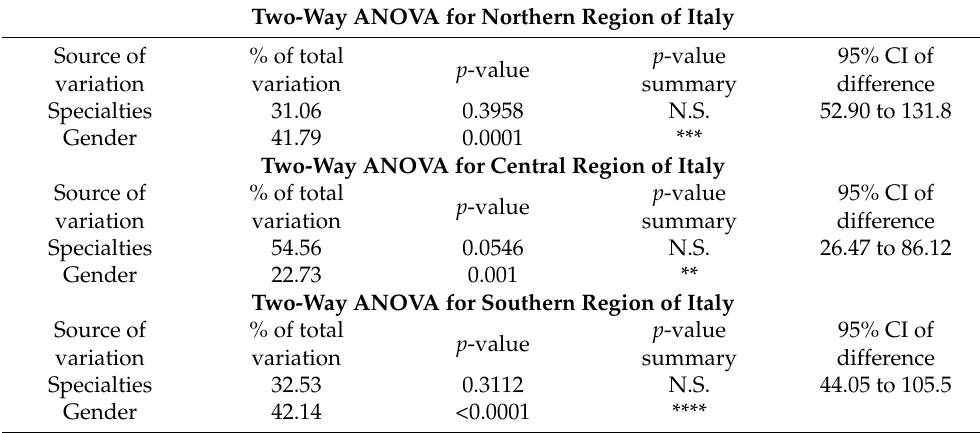
Table 8. Two-way ANOVA of the gender distribution of the speakers in three areas of Italy. In all three areas, the variation in gender was statistically significant. * = level of